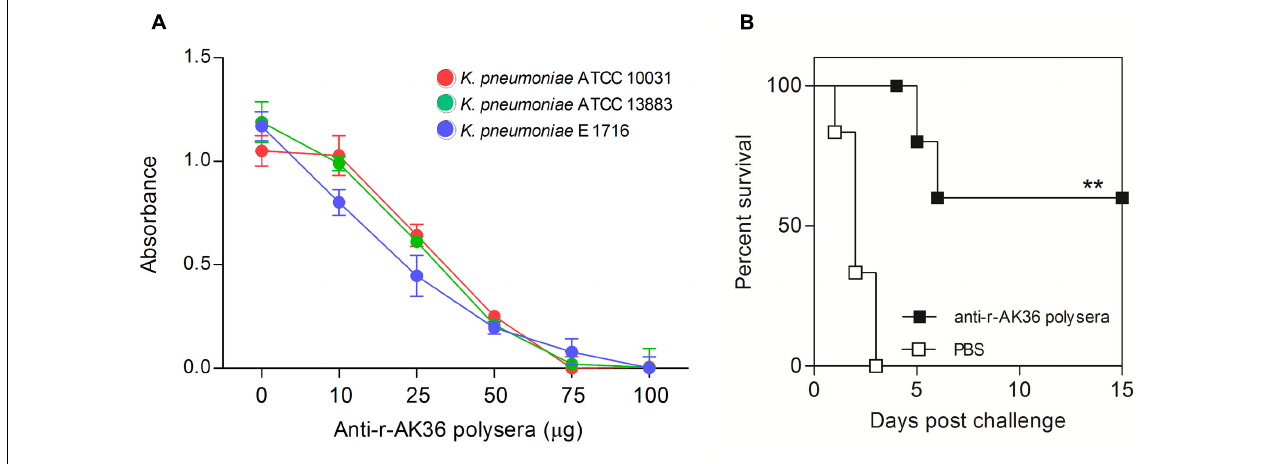
FIGURE 6 | Determination of MIC values of anti-r-AK36 serum and challenge studies on passive immunized mice. (A) MIC values were found to be in the range of 25–50 µ g/ml of polyclonal antibodies against different strains. (B) Survival graph showing passively immunized mice challenged with r-AK36 antigen. Two mice succumbed to death (67% survival) from passive immunized mice compared all six from sham-immunized group. Significance ( P )-value summary: ∗∗ P ≤ 0.01.